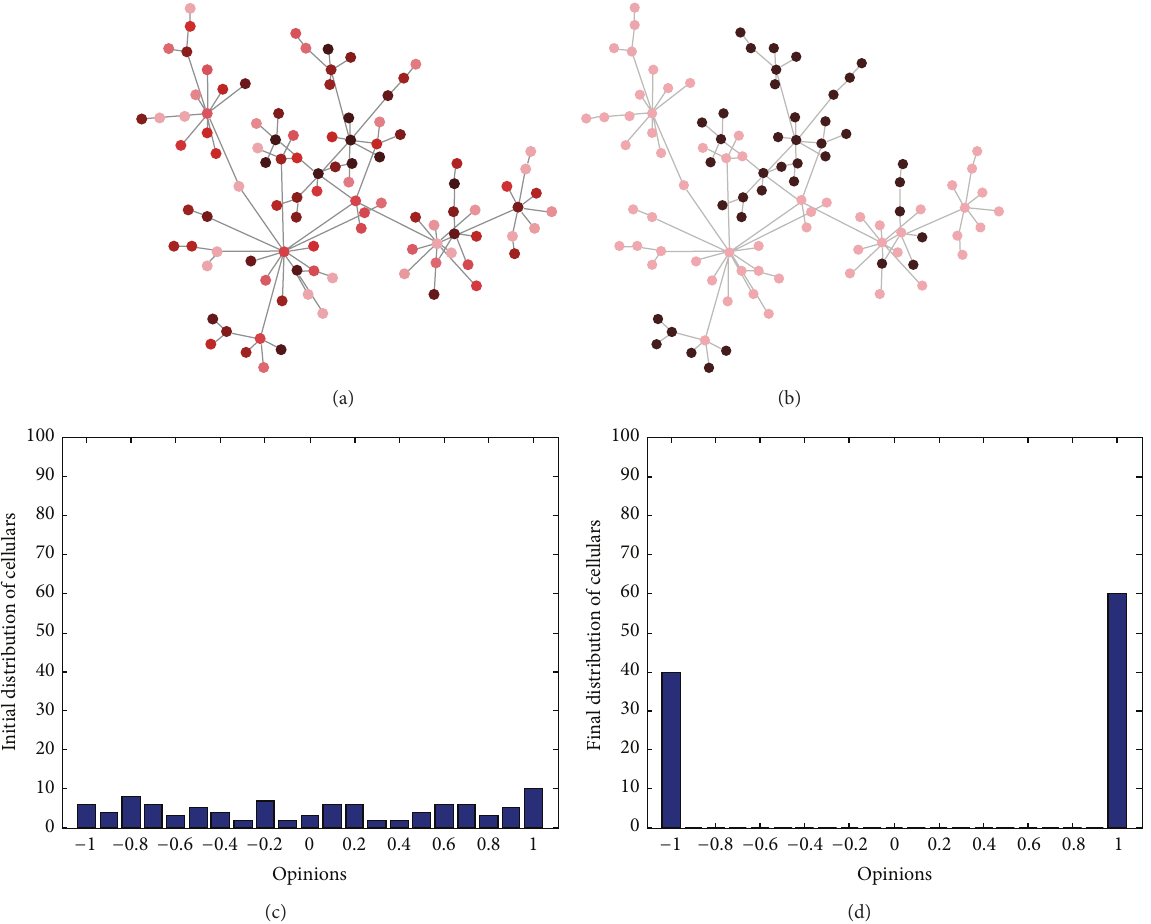
Figure 5: When 𝑎 = 1 , 𝑏 = 𝑐 = 0 , and 𝑁 = 100 , the group shows polarization. In (a) and (b), the color of cellular represents individual’s opinion to Internet events, with more dark meaning more opposition and more light meaning more support. (a) Initial status of group opinions. (b) Distribution of group opinions after 1000 time steps. (c) Histogram of initial distribution of group opinions. (d) Histogram of final distribution of group opinions.